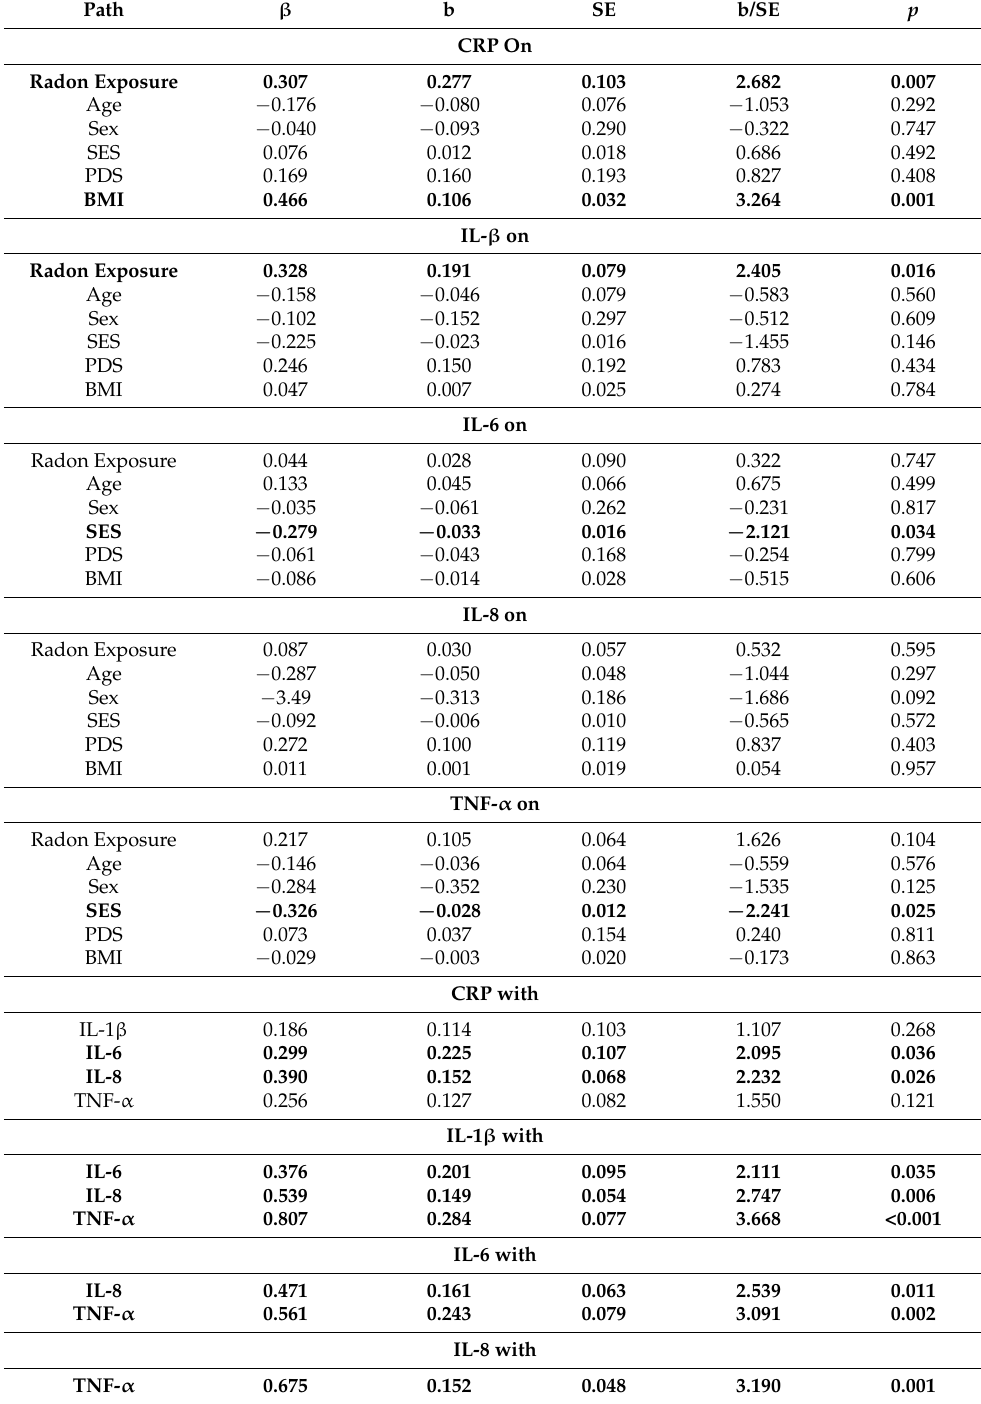
Table 4. Complete model results exploring associations between radon exposure and inflammatory markers, controlling for age, sex, SES, BMI, and